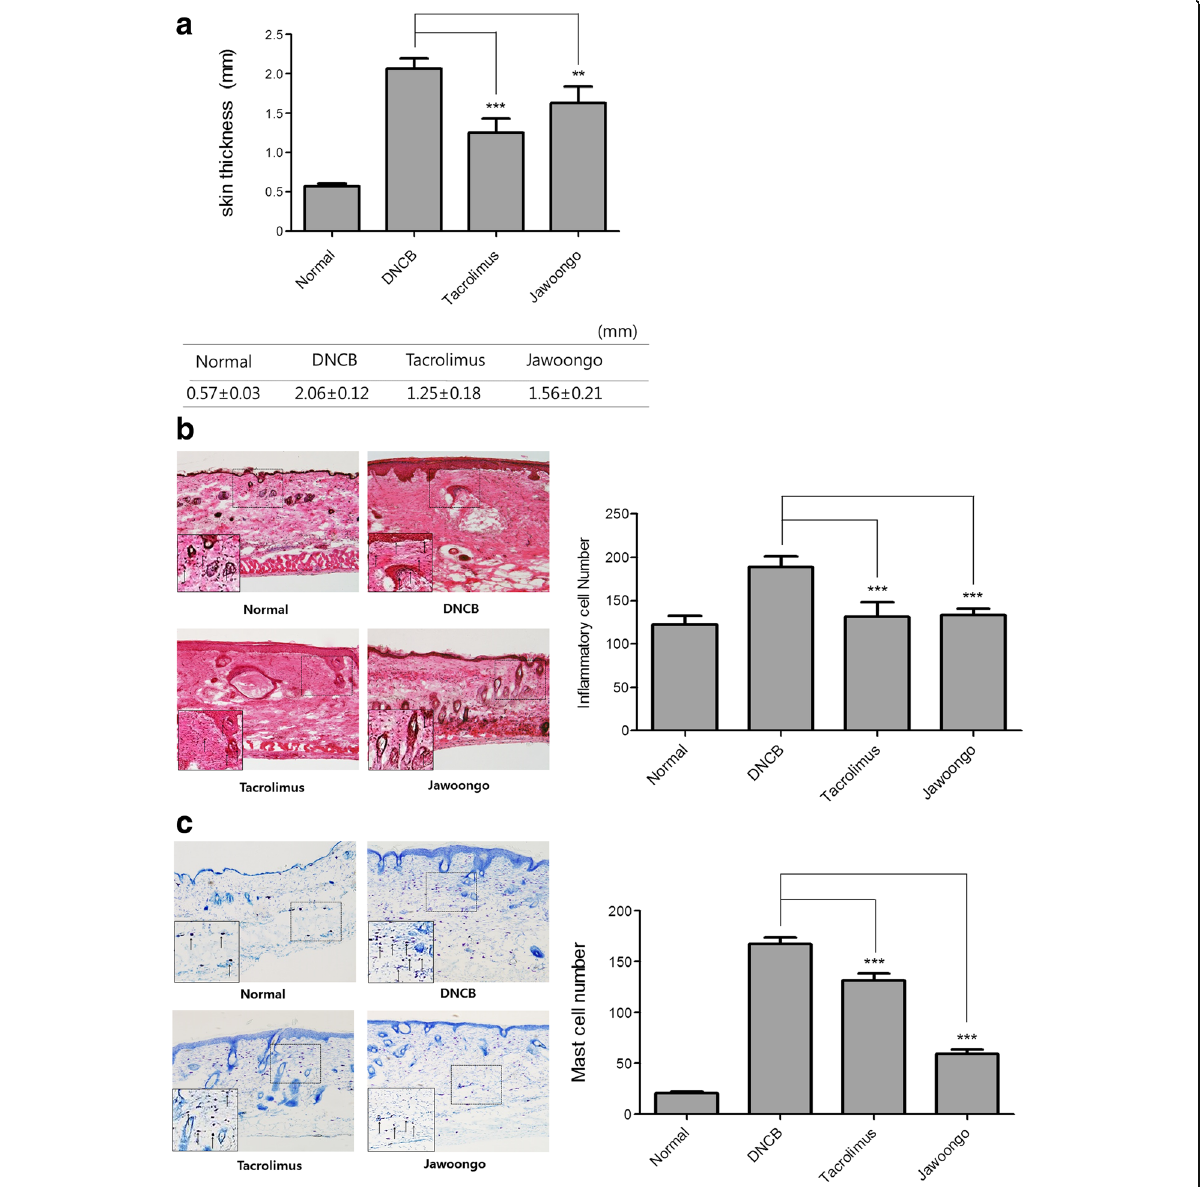
Fig. 2 Effects of Jawoongo on the skin of mice with DNCB-induced AD. Skin thickness in mice with DNCB-induced AD that were treated with Jawoongo ( a ). Jawoongo reduced the infiltration of inflammatory cells into the skin. Skin sections were stained with hematoxylin and eosin ( b ). Arrows indicate inflammatory cells. Jawoongo reduced the infiltration of mast cells into the skin. Skin sections were stained with toluidine blue ( c ). Arrows indicate inflammatory cells. The sections were evaluated under a microscope at an original magnification of 200×. The data were presented as mean ± SEMs ( n = 8 mice/group). * P < 0.05, ** P < 0.01 and *** P < 0.001 as compared to DNCB-stimulated group,